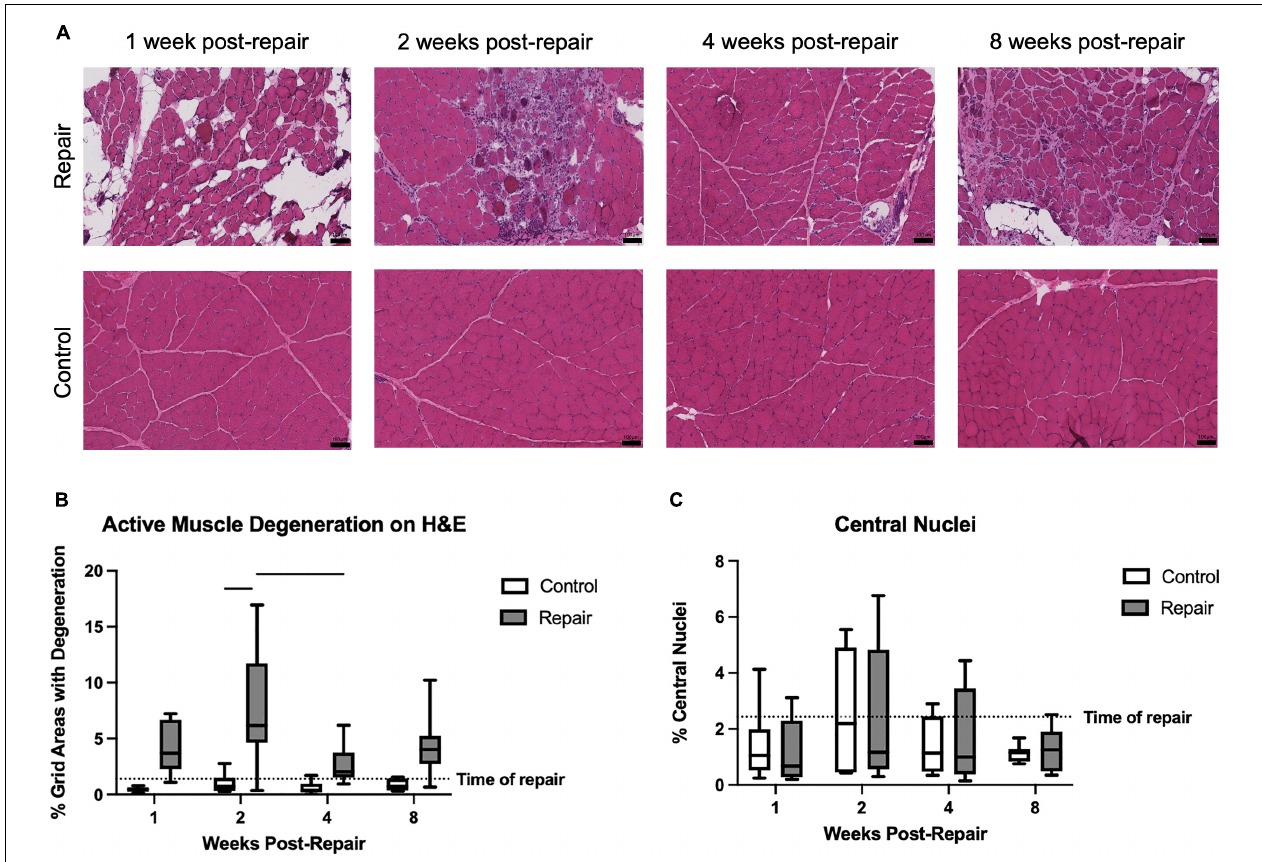
FIGURE 2 | Representative H&E images of repaired and unoperated control supraspinatus muscle at various timepoints (A) . Significant active muscle degeneration was seen at 2 weeks post-repair, compared to contralateral, which decreased at 4 weeks (B) . No significant regeneration, represented by percentage of centralized nuclei, was observed (C) . Data presented as mean ± SD for bar graph, or minimum and maximum for box plot, N = 8 per timepoint. Significant comparisons ( p < 0.05) within timepoint or within treatment group are indicated by horizontal line. Dotted line represents historical control data from previous study (Vargas-Vila et al., 2021) at 8 weeks after tenotomy (time of